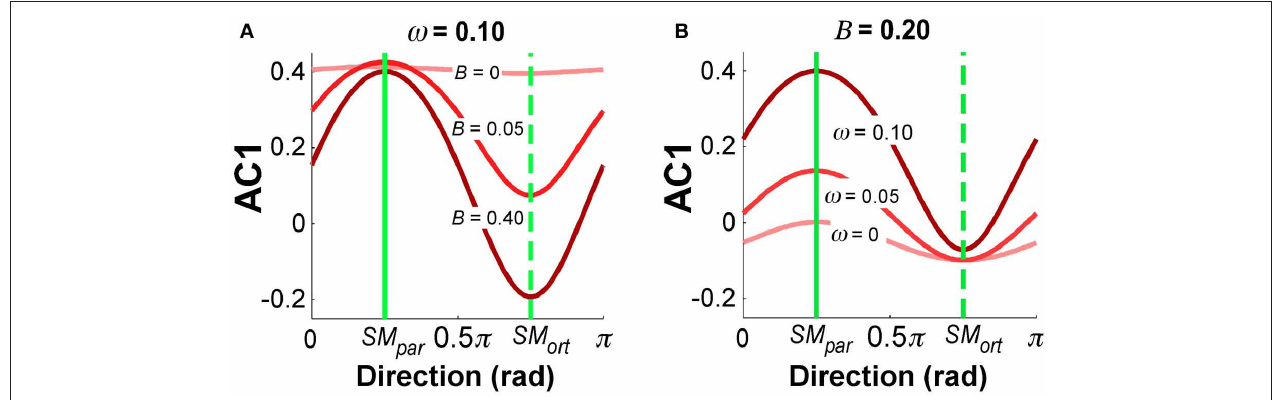
FIGURE 9 | Simulation results for autocorrelation AC1 as a function of direction angle. (A) B = 0 . 20 and ω = 0, 0.05, 1.0. (B) ω = 0 . 1 and B = 0, 0.05, 0.40. The values depict average results from 100 simulation runs for each direction angle.